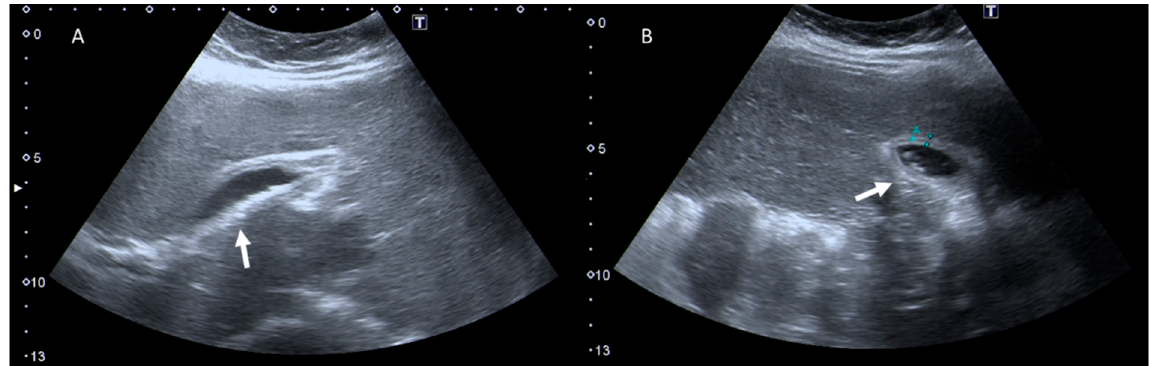
Figure 2. Pregnant woman with emergency room admission for right abdominal pain and fever. US assessment ( A , B ) shows (arrows) thickening of the gallbladder walls, with intraluminal hyperechoic material.